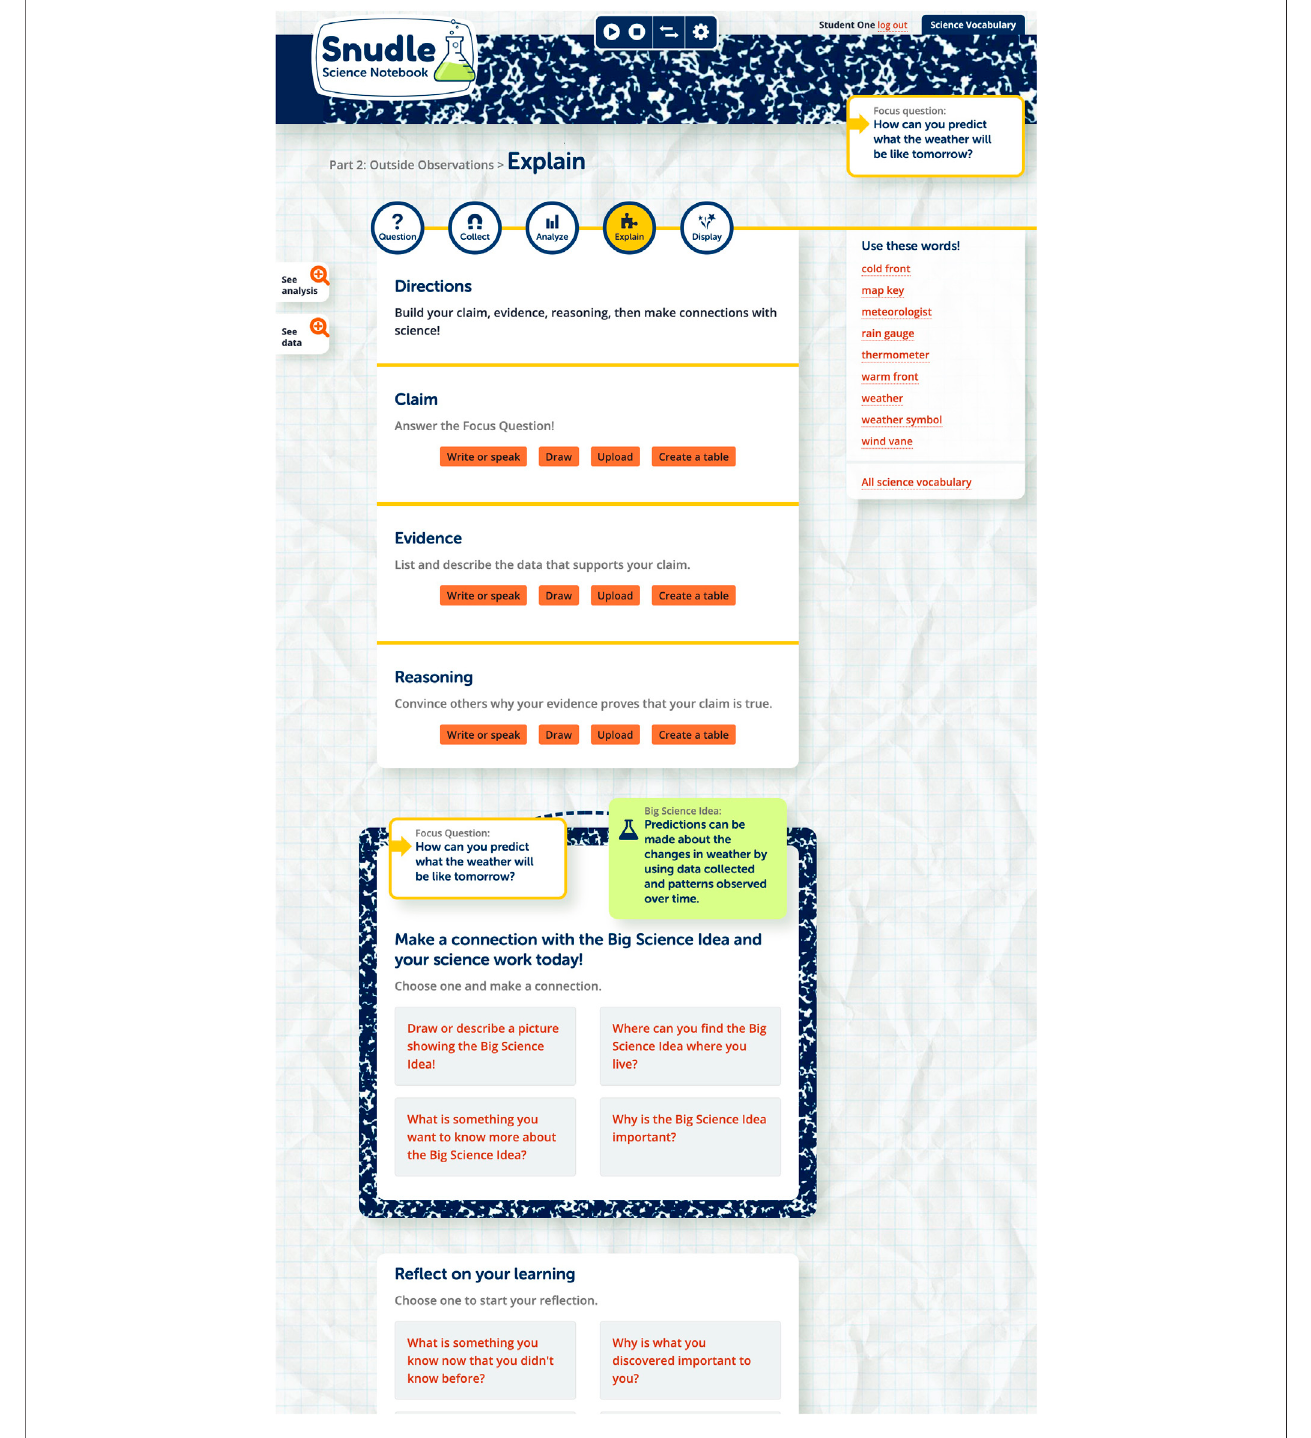
FIGURE1| Screenshotofthe “ Explain ” pageinSNDULEinwhichstudentssummarizetheiranalysisofthedataandprovidetheirevidenceandreasoningastohow the experiment they conducted answers the focus question.